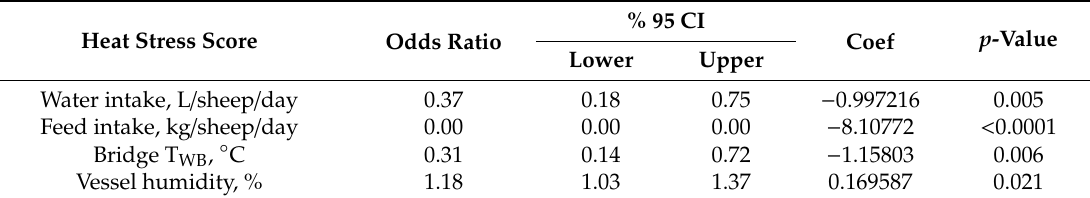
Table 5. Variables significantly ( p < 0.05) related to heat stress score (1 = normal, 2 = moderate and 3 = severe) by ordinal logistic regression: with data from 14 voyages and 22–30 days for each voyage.